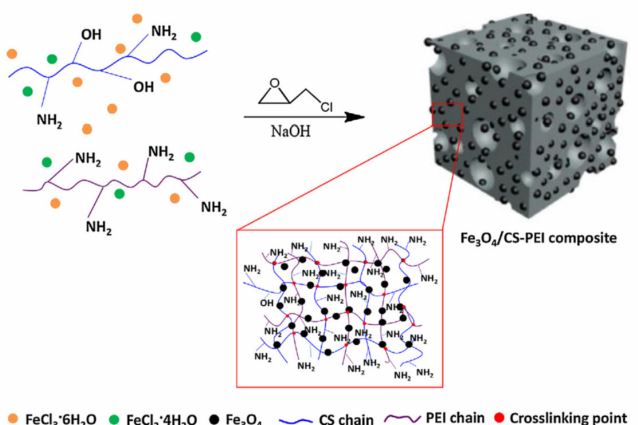
Figure 10. Synthesis of composite gel based on F 3 O 4 and CS/PEI (reprintedwith permission from ref.